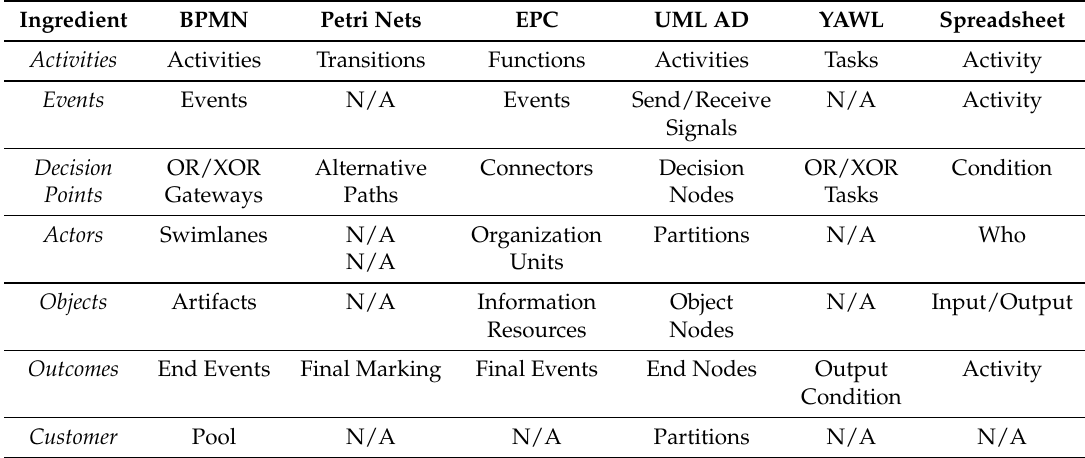
Table 2. Business process ingredients represented by different modeling